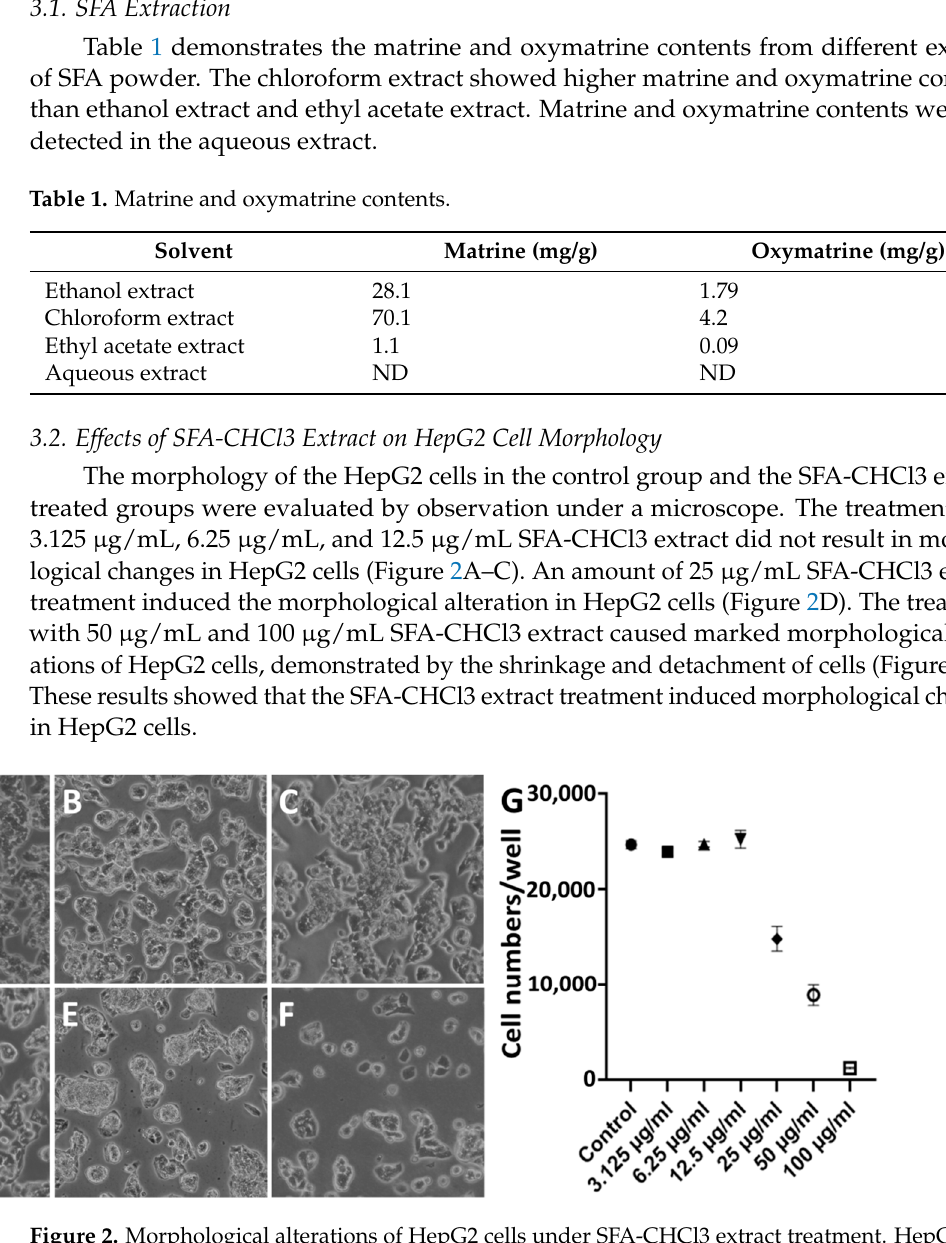
Figure 2. Morphological alterations of HepG2 cells under SFA-CHCl3 extract treatment. HepG2 cells from the treatment of 3.125 µg/mL ( A ), 6.25 µg/mL ( B ), and 12.5 µg/mL ( C ) SFA-CHCl3 extract showed normal morphology. HepG2 cells showed morphological changes in 25 µg/mL ( D ), 50 µg/mL ( E ), and 100 µg/mL ( F ) SFA-CHCl3 extract groups. ( G ) Cell density was analyzed by WST-1 assay. Original magnification